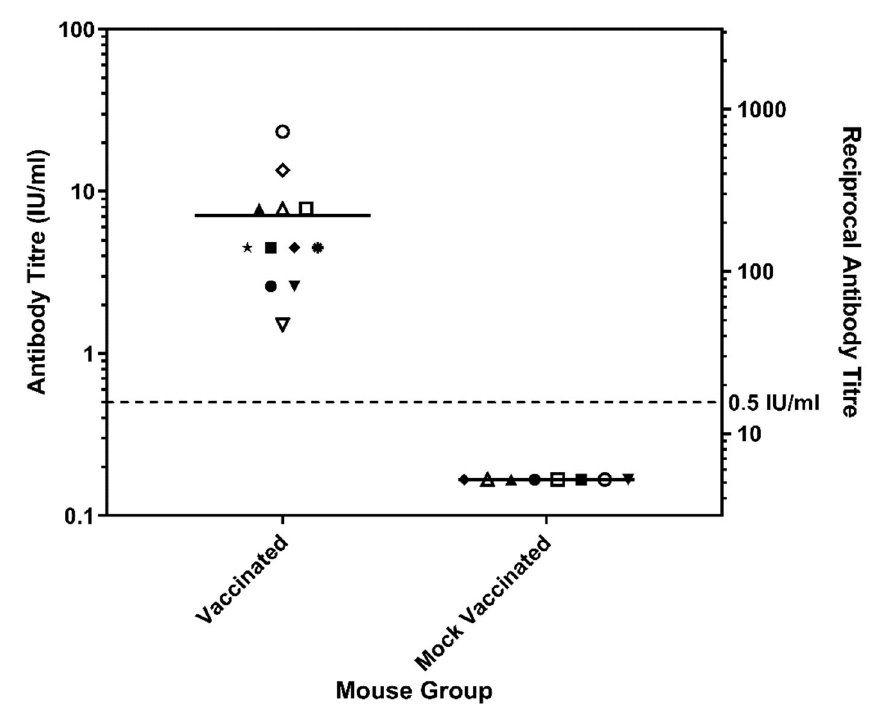
Figure 5. Post ‐ vaccination serology on day 21 for mice vaccinated with VeroRab and mice mock vaccinated with MEM on days 0 and 7. All sera, each assigned a different symbol on the graph, were assessed for neutralizing antibodies by FAVN and plotted on a logarithmic scale.